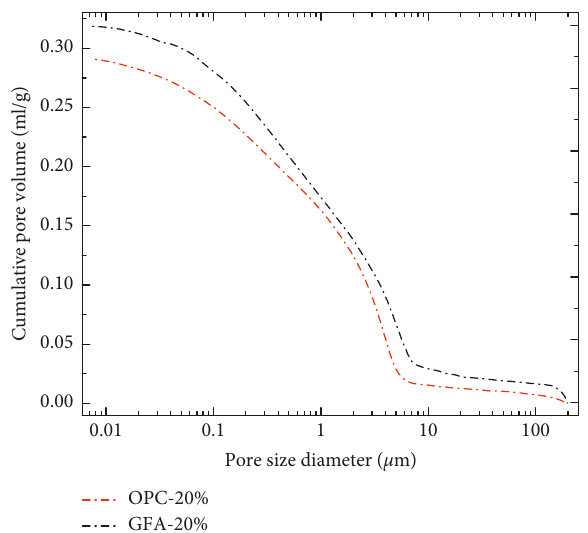
Figure 7: Cumulative pore volume of the solidified/stabilized soils.